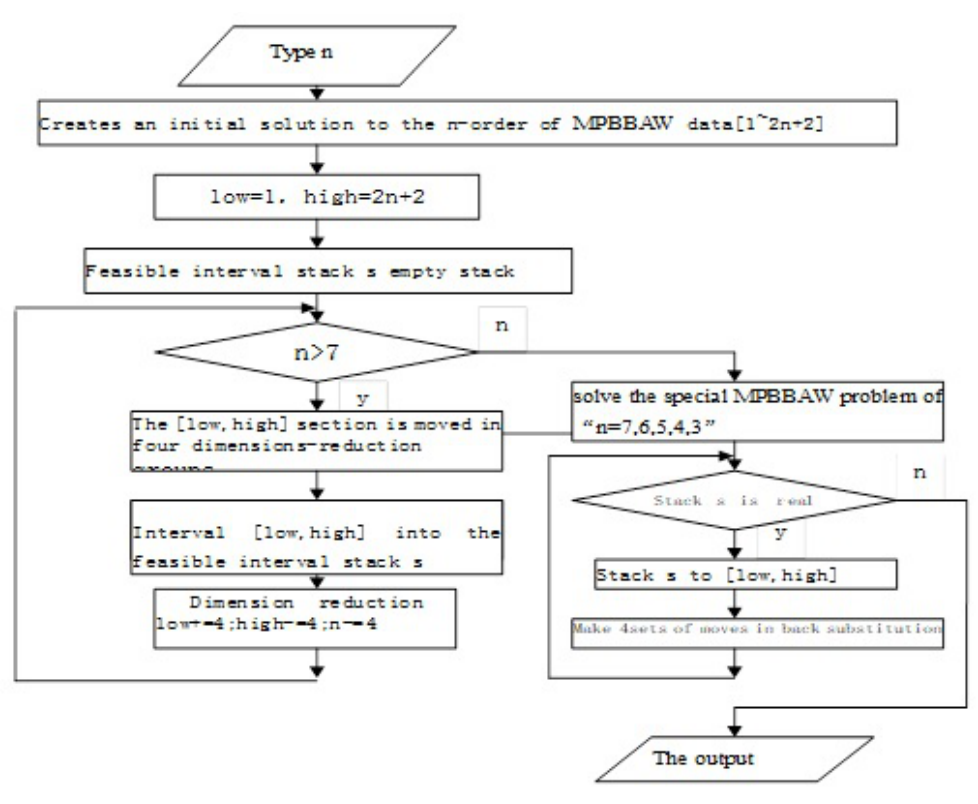
Fig. 1 The flow chart of the algorithm of the MPBBAW problem white strings of the middle